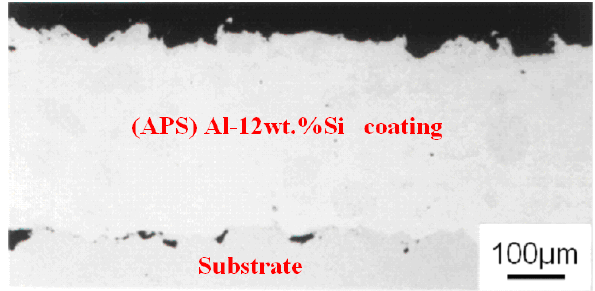
powder feed rates. Only layers deposited with the pow-